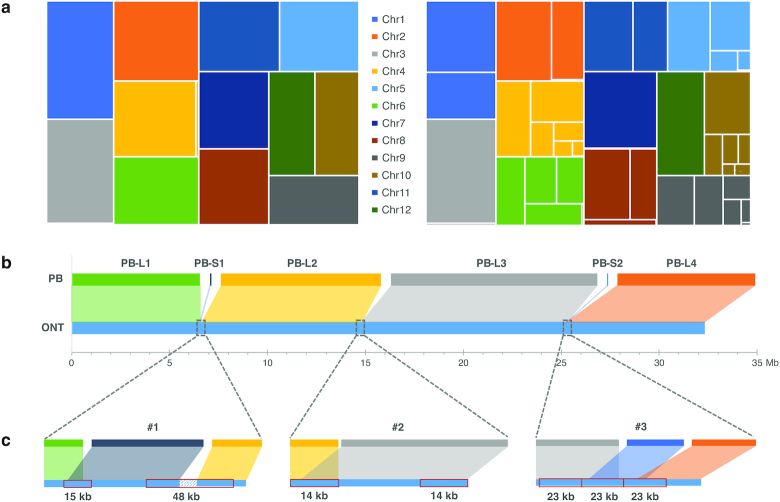
Contiguity of the ONT and PacBio assemblies. (a) Treemaps for contig length difference between the ONT (left) and PacBio (right) assembly; (b) the 6 PacBio contigs mapped to 1 ONT contig corresponding to Chr. 6; (c) details of the 3 PacBio gaps. Red rectangles indicate repeat elements.